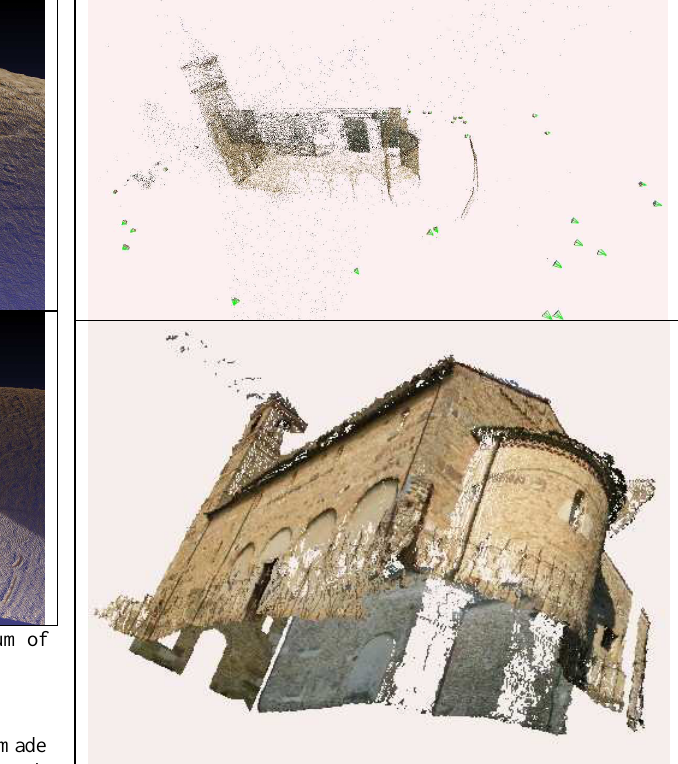
Figure 11. Results on Pozzovegiani, with only tie points and with dense matching.